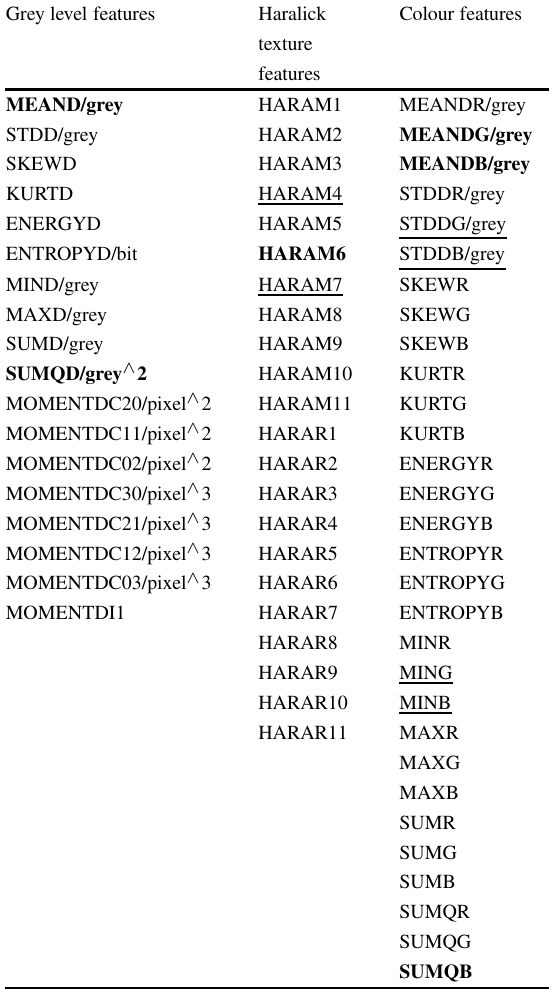
Measurement features obtained for each element. For detailed infor- mation see [3] and [8]. Features which were crucial for differentiat- ing between various classes of elements are highlighted (background versus tissue: italic; CK immunopositive versus “other” tissue ele- ments: bold; LCA immunopositive versus “other” tissue elements: